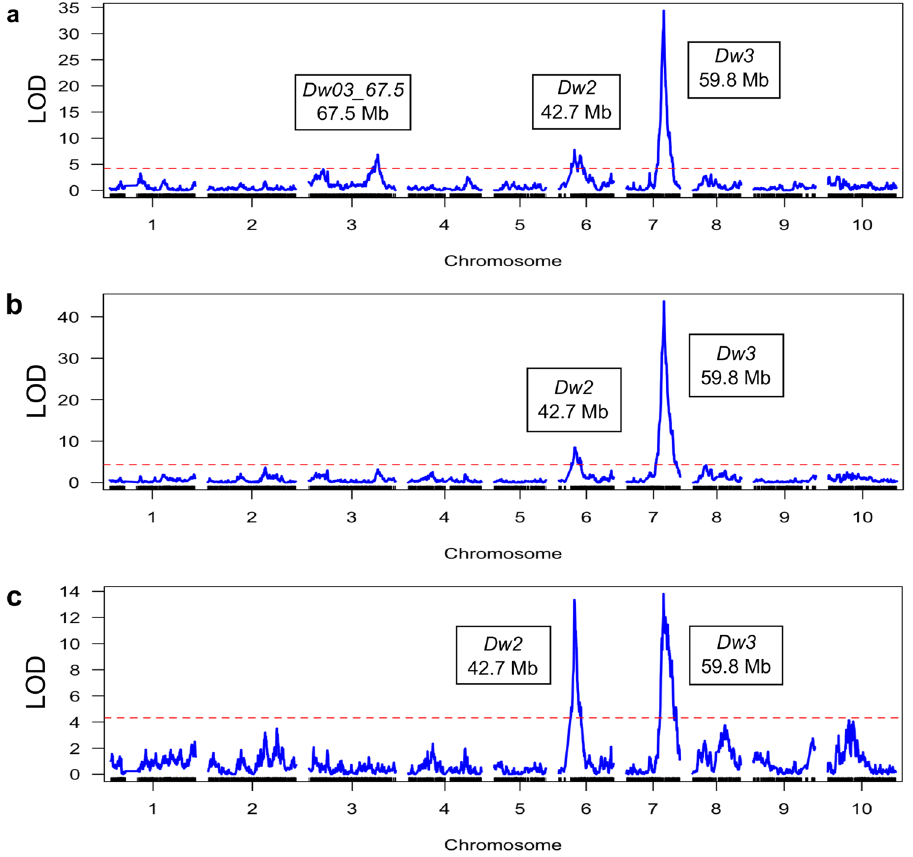
Figure 1. QTL identified using the BTx623 x IS3620c RIL population. The RIL population was grown in the greenhouse and genotyped using DG. Stem length ( a ) was measured from the base of the plant to the base of the panicle. Genetic map generation and QTL mapping were performed in R/qtl using interval mapping (IM). The x-axis is the markers along the chromosomes and the y-axis is the LOD score. The significant QTL peaks are labeled with the Dw locus and location (Mb). Stem length ( a ), average internode length ( b ), and the length of the first internode below the peduncle ( c ) are